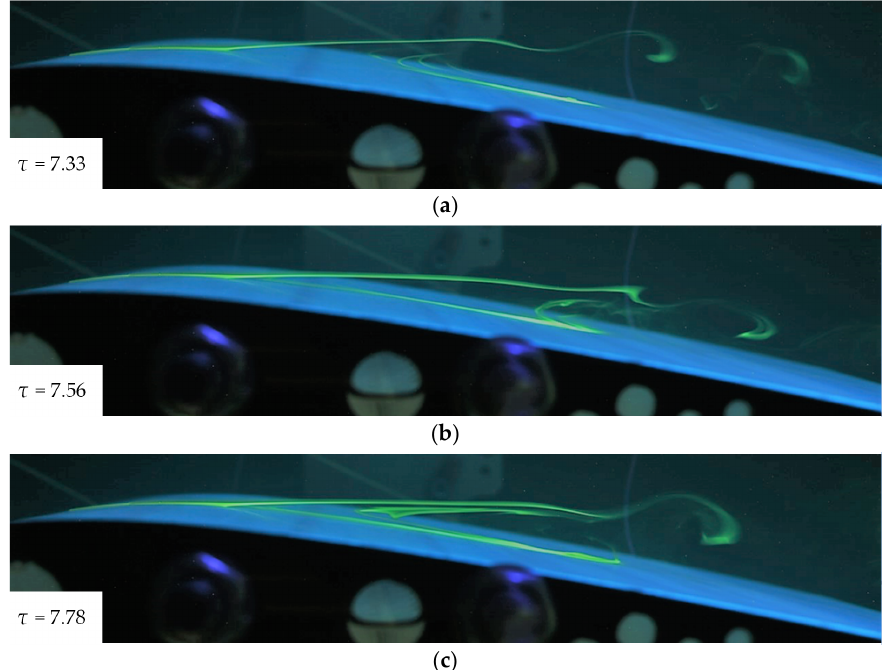
Figure 15. Flow images for standard Risø at Re = 2 × 10 4 , α = 6°: ( a ) τ = 7.33; ( b ) τ = 7.56; ( c ) τ = 7.78.